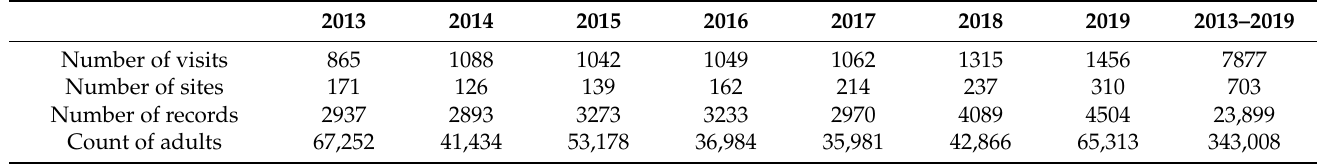
Table 1. Some general results of the Cyprus Dragonfly monitoring schemes for the period 2013 to 2019.